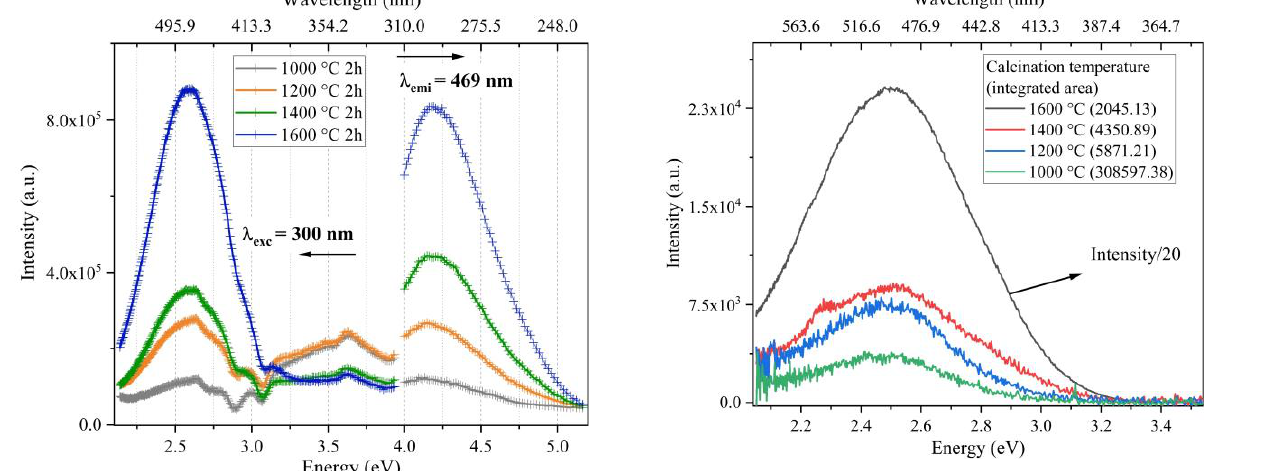
Fig. 1. Emission (λ exc =300 nm) and excitation (λ emi =469 nm) spectra for HfO 2 at different temperatures of calcination .